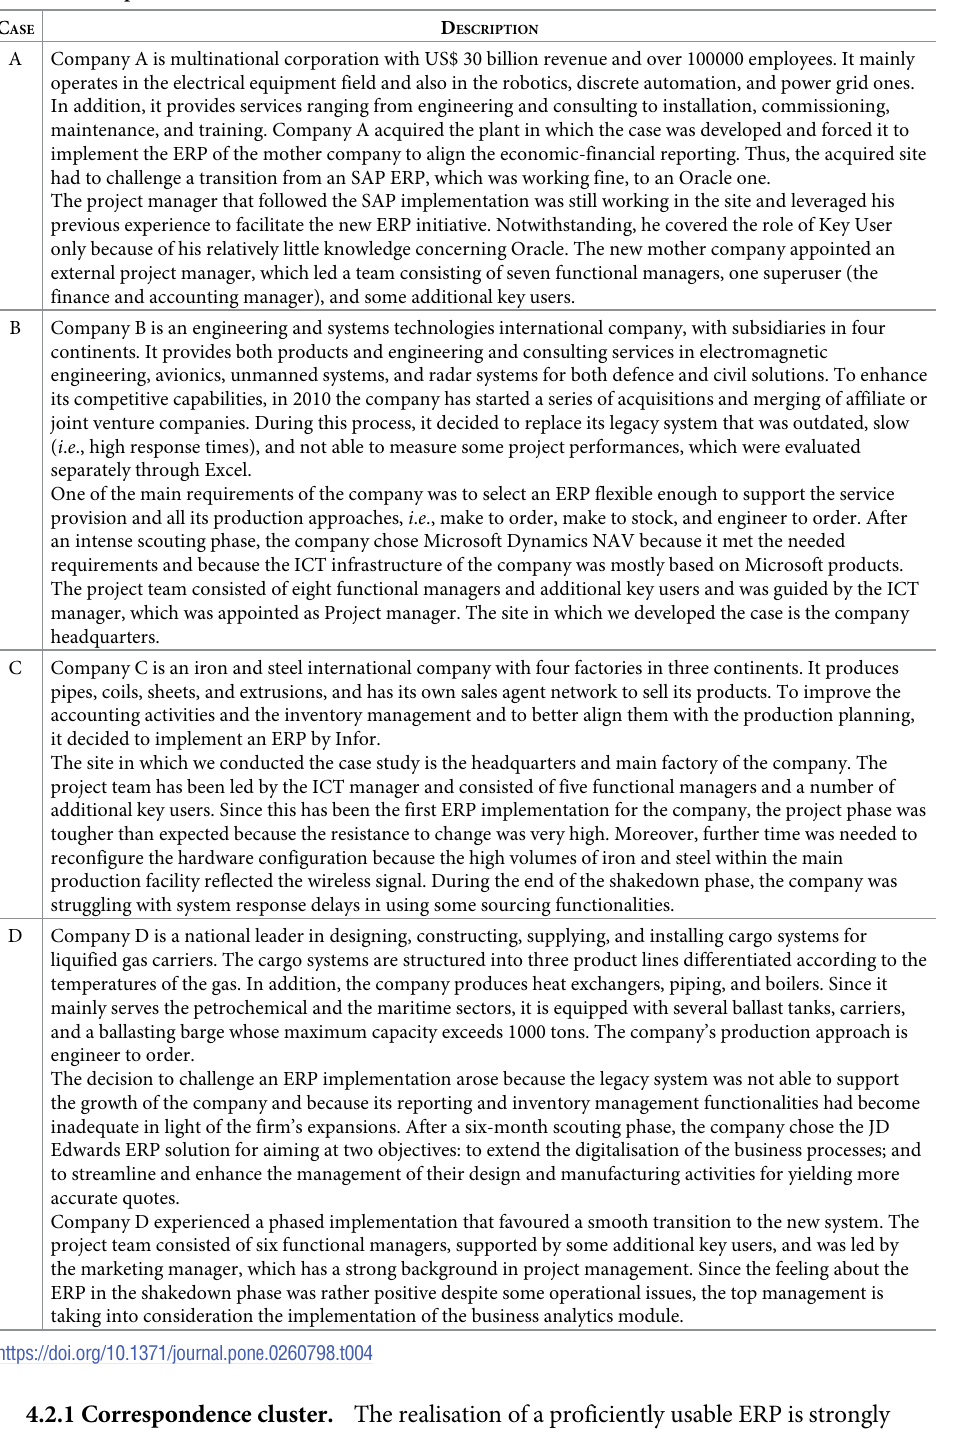
Table 4. Description of the